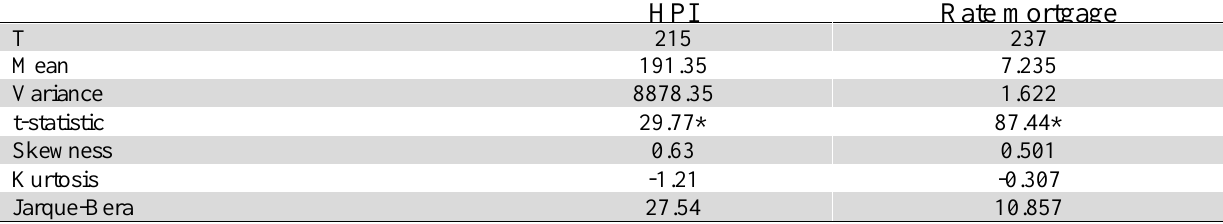
Descriptive statistics of House Price Index (HPI) and the mortgage market